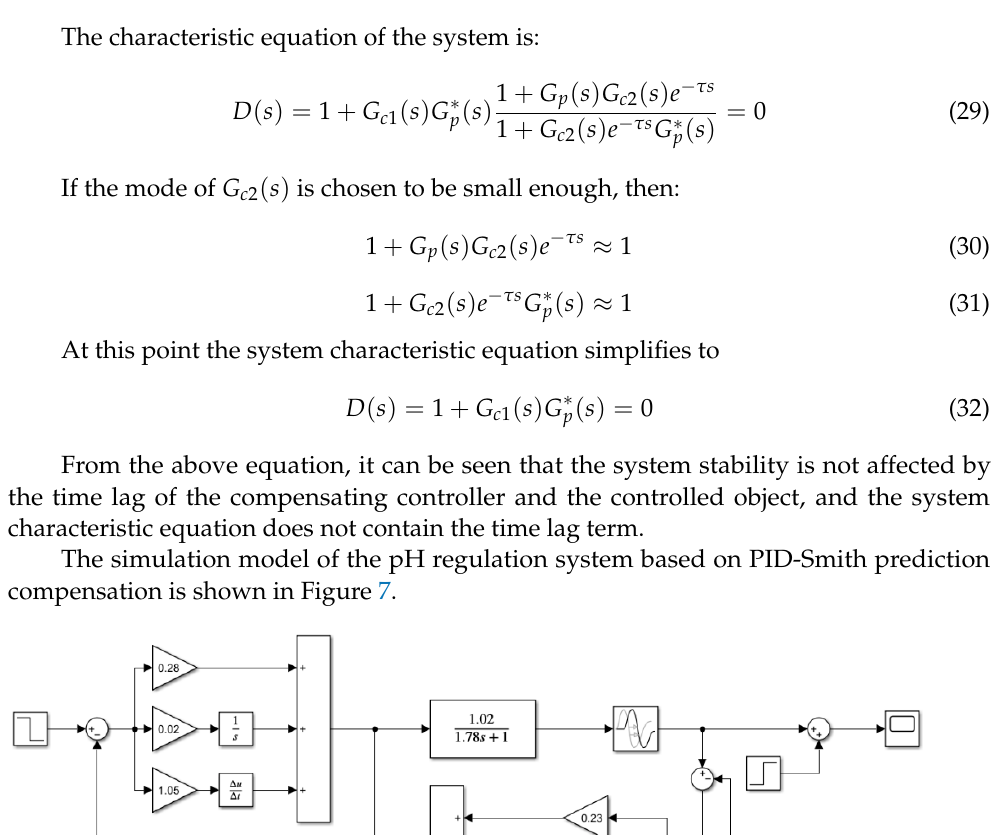
Figure 8. Structure of PID control system based on BP neural network. The structure consists of a conventional PID and a BP neural network. The conven- tional PID realizes the closed-loop feedback control of the controlled object, and the BP neural network finally obtains the optimal PID control parameters of the system by con- tinuously updating iterations according to the system state and learning algorithm. The neural network structure in Figure 8 is shown in Figure 9 below.